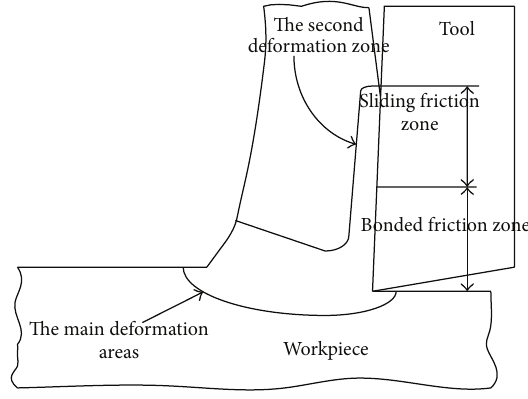
Figure 1: Two-dimensional model of cutting